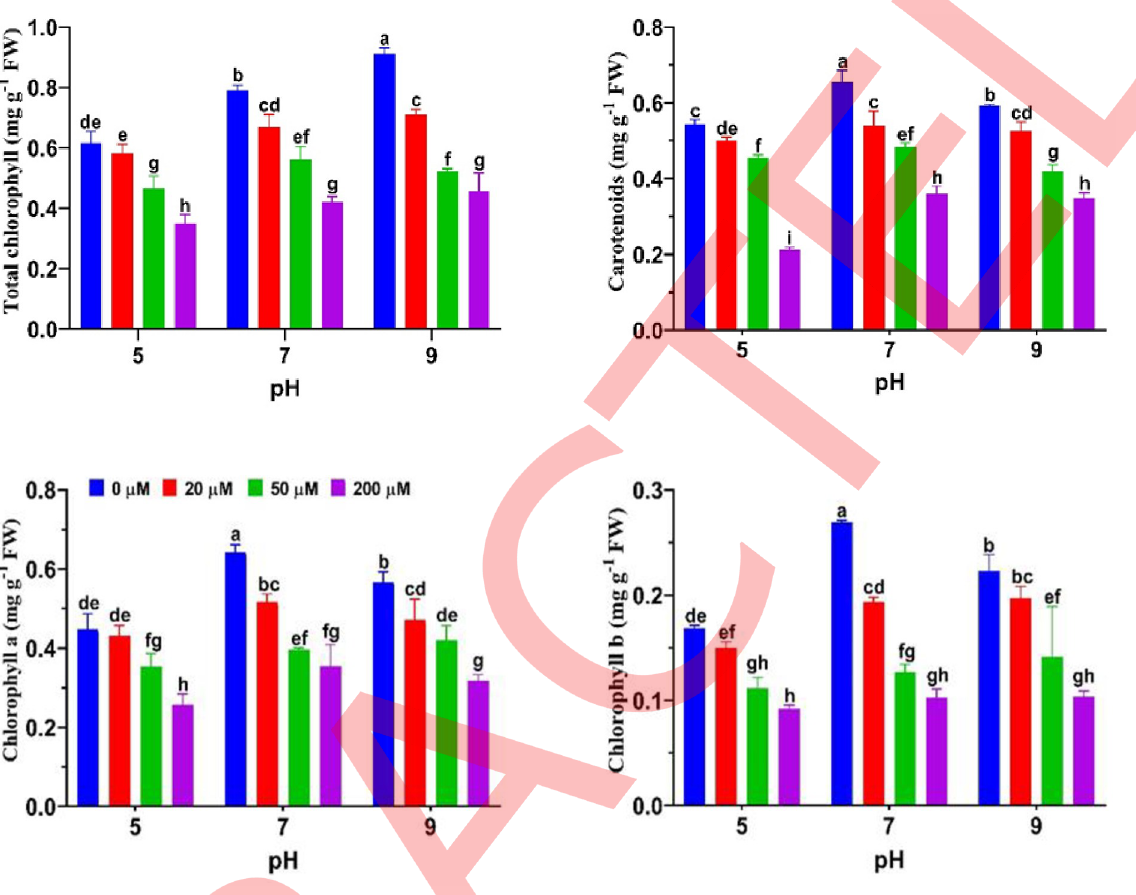
Fig 2. Effect of three different levels of pH (5, 7, and 9) on leaf photosynthetic pigments and carotenoids contents of cadmium (0, 20, 50, and 200)-stressed wheat